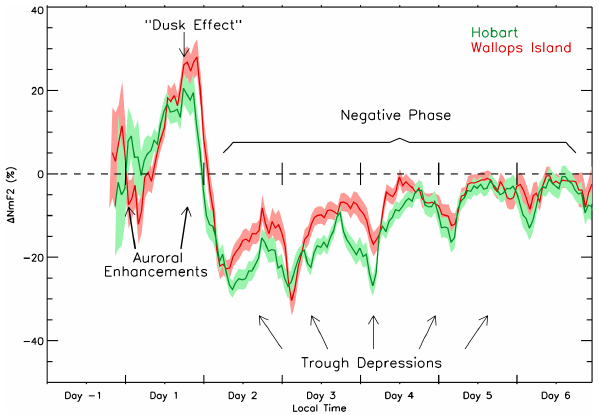
Fig. 5. The resultant average storm patterns in local time for all storms as observed at Wallops Island (red) and Hobart (green), shown as percentage changes in Nm F2 at hourly intervals, as reck- oned from monthly mean conditions at each station. The arrange- ment of the storm periods prior to averaging are shown in Figs. 3 and 4. The characteristic features of the positive phase (a dusk ef- fect on Day 1 and auroral enhancements on Days − 1 and 1) are in- dicated. The characteristic features of the negative phase (daytime depletions and post-midnight trough effects) are also indicated. As in Fig. 1, shadings give the uncertainty of the mean for the com- puted mean